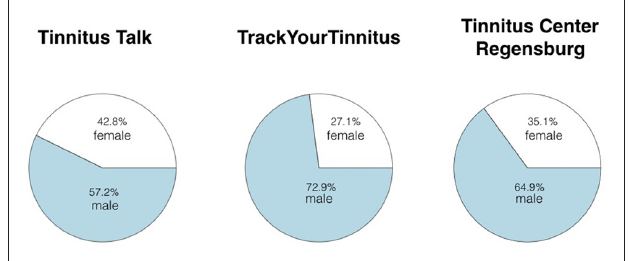
FIGURE 2 | Distribution of gender in the three samples.